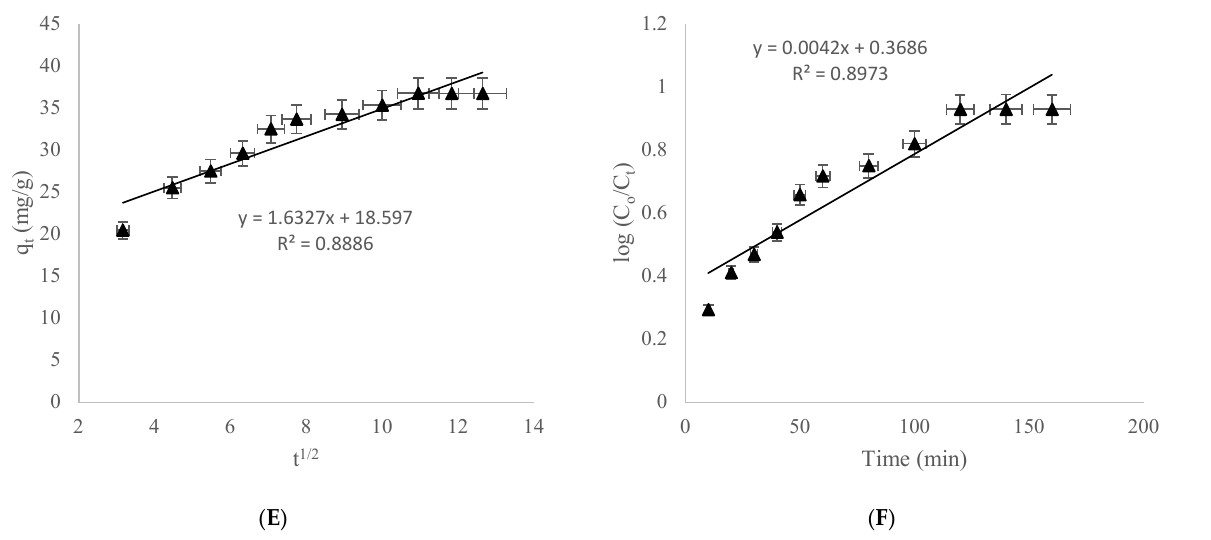
Figure 5. ( A ) Impact of contact time; ( B ) pseudo-first-order kinetic model; ( C ) pseudo-second-order kinetic model; ( D ) power function kinetic model; ( E ) intraparticle kinetic model; ( F ) Natarajan–Khalaf kinetic model.